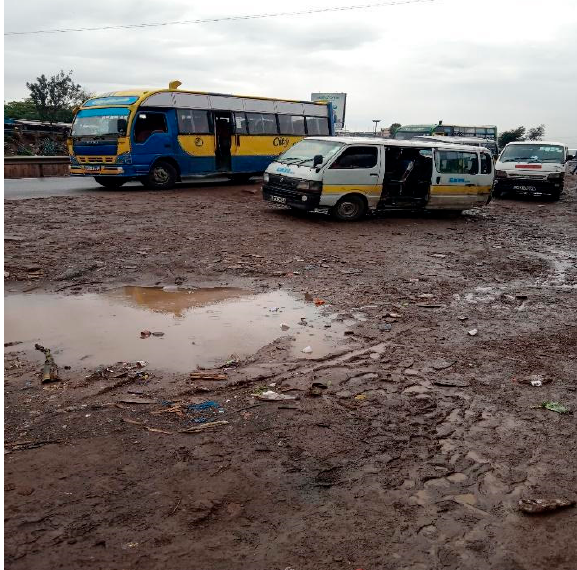
Figure 6. “This is a matatu (minibus or similar vehicle used as a taxi) …where I work this is where I get some money. And the money you know that it is for supper, breakfast and lunch and other responsibilities” (Daniel, 17-year-old boy,